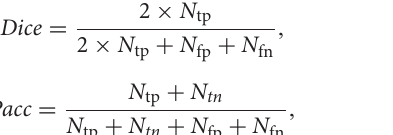
diagnosis of bladder cancer) as the ground truth for